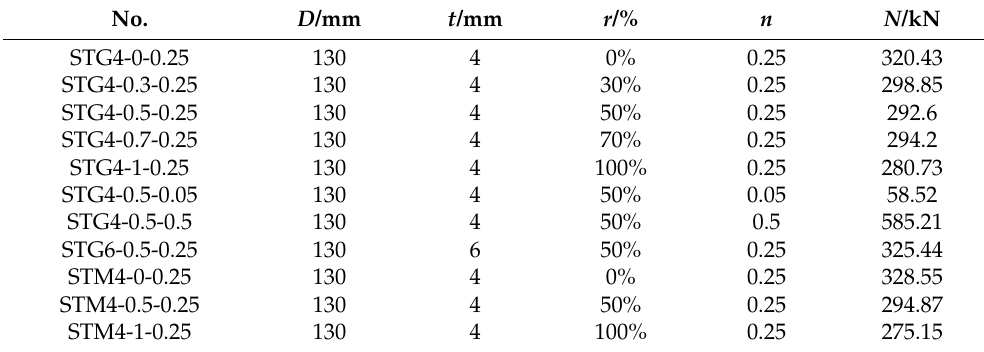
Figure 1. Geometric details of the proposed composite column. Table 1. Design parameters of